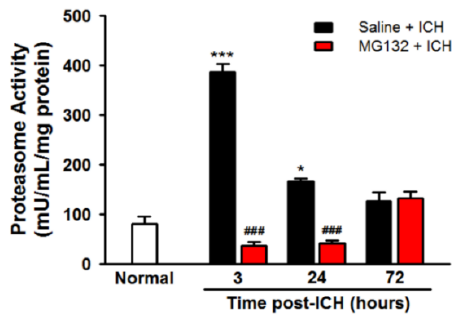
Figure 3. ICH induced acute proteasome over-activation. The proteasome activity was measured by fluorometric assay in ipsilateral striatal lysates at normal, 3, 24, and 72 h post-ICH. Values are indicated by means ± SEM; n = 6 each group, * p < 0.05; *** p < 0.001; compared to the normal group; ### p < 0.001; compared to the Saline + ICH group, respectively.